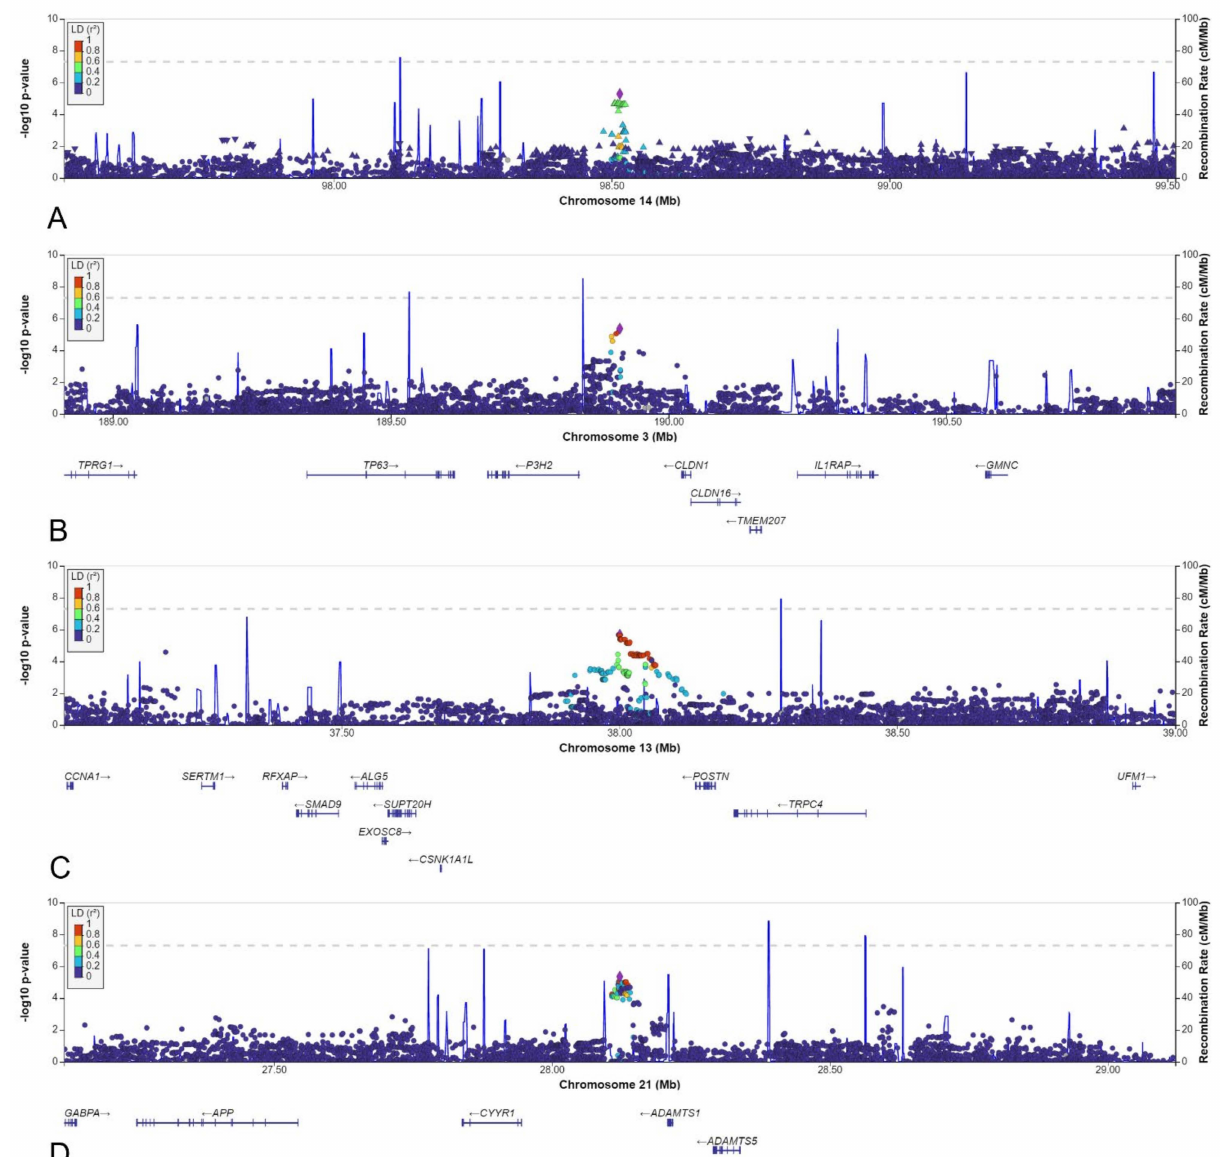
Figure 7. LocusZoom plots for: ( A ) rs148251525. ( B ) rs10433490. ( C ) rs9547854. ( D )